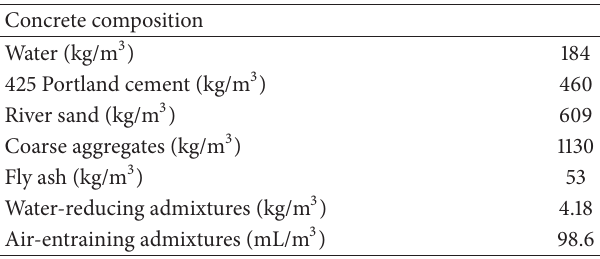
Table 1: Proportions of concrete